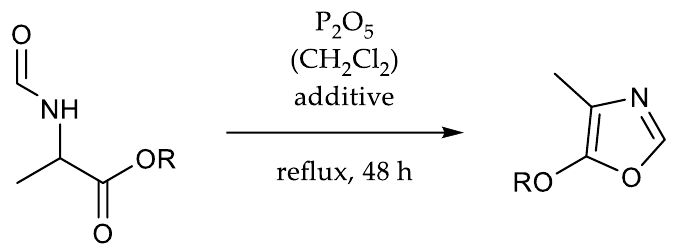
Table 2. Reaction conditions for the N-formylation of alanine alkyl esters.